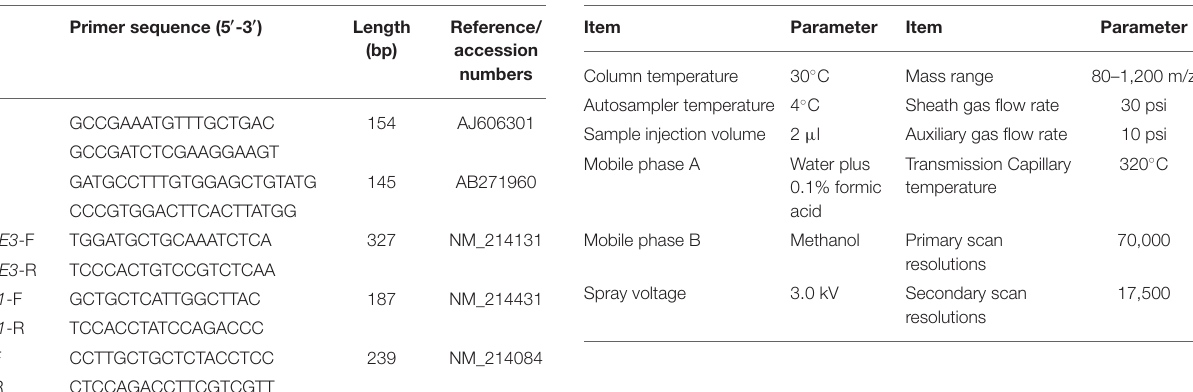
TABLE 1 | Quantitative real-time PCR primers of genes. TABLE 2 | Instrument operation program of UPLC-MS/MS